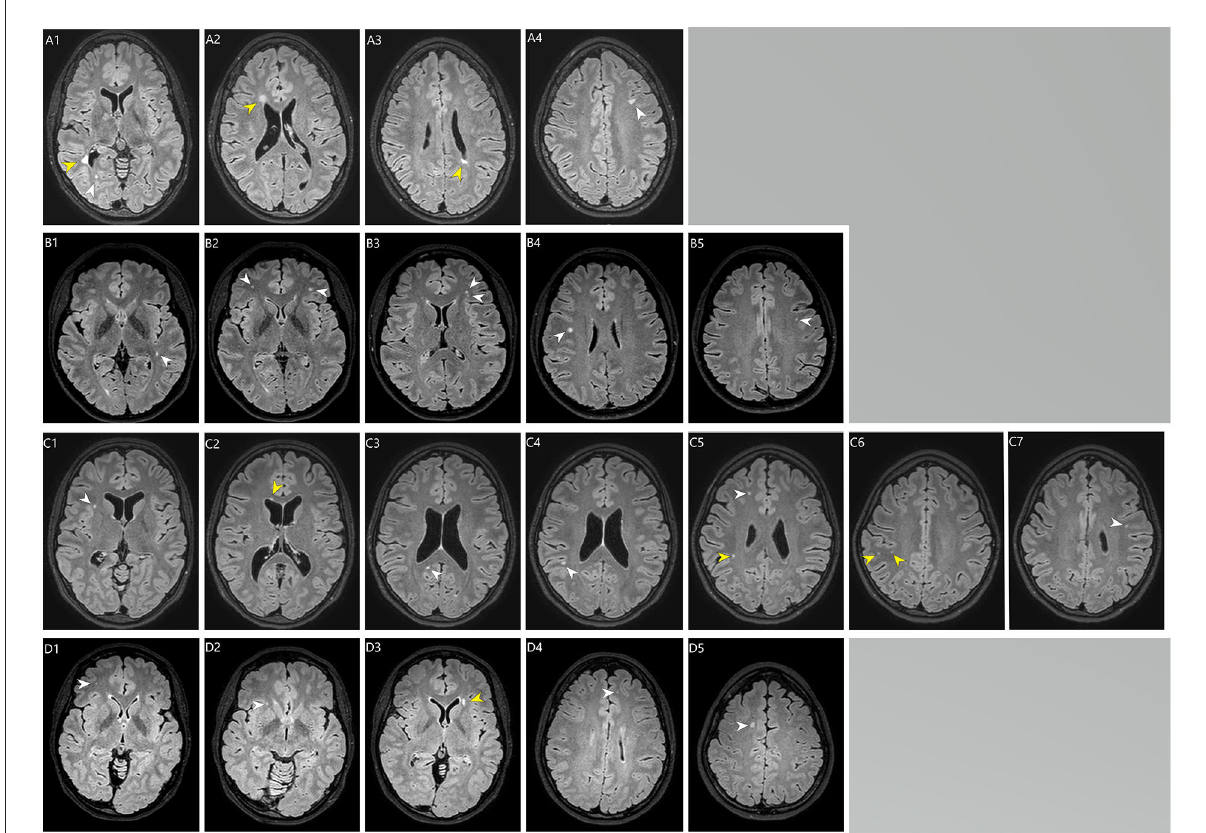
FIGURE2 Brain MRI (T2-flair) of the white matter hyperintensities in four cases (Kawasaki disease). (A1–A4) a case (Kawasaki disease) with a total Scheltens’ score of 8. (A1) Periventricular WMH > 5mm in the right occipital horn (yellow arrow; Scheltens’ score = 2) and in the deep occipital lobe WMH < 3mm (white arrow; Scheltens’ score = 1). (A2) Periventricular WMH > 5mm in the right frontal horn (yellow arrow; Scheltens’ score 2). (A3) Periventricular WMH > 5mm in the left ventricle (yellow arrow; no score, because already score has been given from this area). (A4) deep WMH 4–10mm in the left frontal lobe (white arrow; Scheltens’ = score 3). (B1–B4) a case (Kawasaki disease) with a total Schelten score of 6. (B1) deep WMH 4–10mm in the left temporal lobe (white arrow; Scheltens’ score = 3). (B2–B5) multiple deep WMH in the both frontal lobes (white arrows), in the (B2) (left white arrow) and (B4) (white arrow) the size of the largest WMHs are 4–10mm (Scheltens’ score = 3). (C1–C7) a case (Kawasaki disease) with a total Schelten score of 6. (C1,C5,C7) multiple deep WMH < 3mm in the frontal lobes (white arrows; Scheltens’ score = 1). (C2) periventricular WMH ≤ 5mm in the right frontal horn (yellow arrow; Scheltens’ score = 1). (C3) deep WMH < 3mm in the right occipital lobe (white arrow; Scheltens’ score = 1). (C4) (white arrow), (C5) (yellow arrow) and (C6) (yellow arrows): deep WMHs in the right parietal lobe, in the (C4) (white arrow) size of WMH is 4–10mm (Scheltens’ score = 1). (D1–D5) a case (Kawasaki disease) with a total Schelten score of 5. (D1,D2,D4,D5) Deep WMHs in the frontal lobes (white arrows). In the (D5) (white arrow) the size of the WMH is 4–10mm (Scheltens’ score = 3). (D3) periventricular WMH size > 5mm next to left frontal horn (yellow arrow; Scheltens’ score =